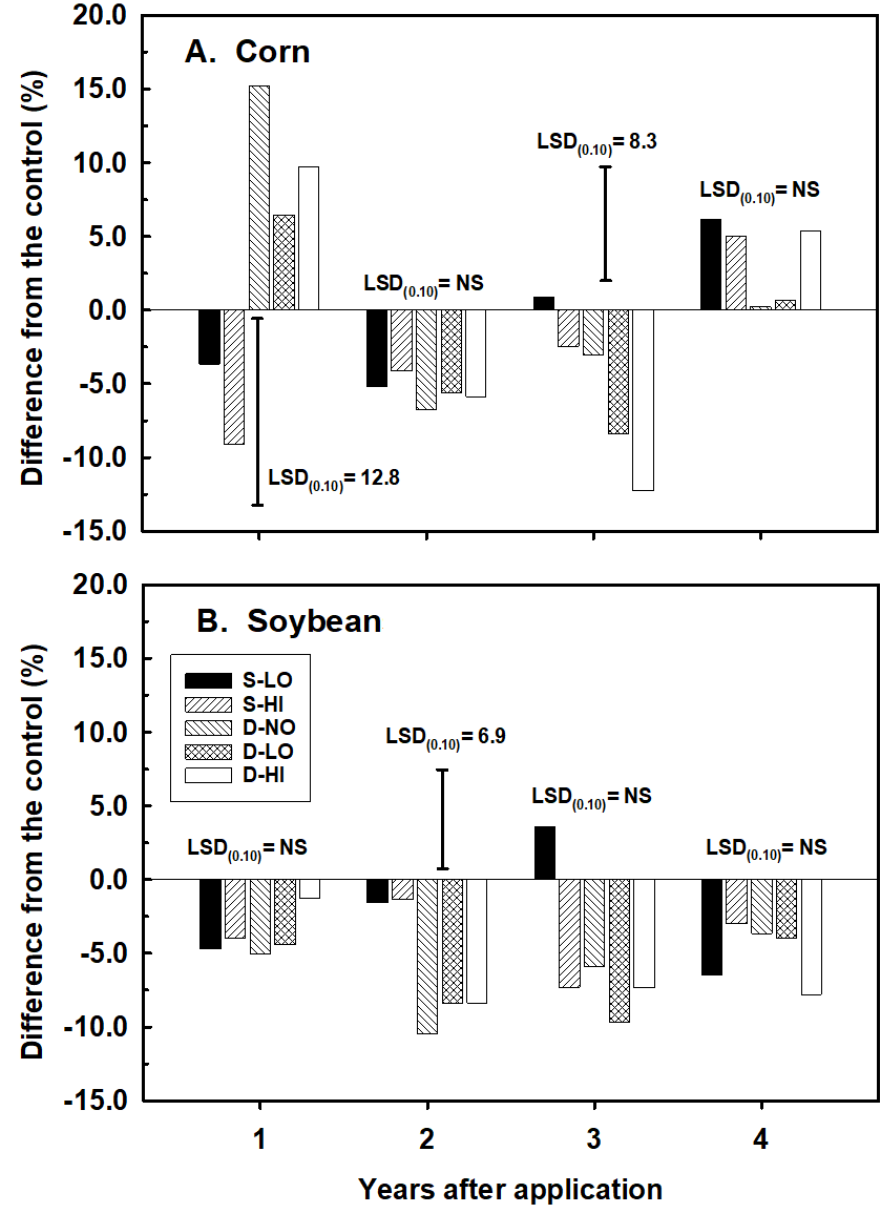
Figure 6. ( A , B ) Grain yield differences from the control plots for ( A ) corn and ( B ) soybean in response to lime treatments for all trials 1 to 4 years after treatments were initially applied. LSD (0.10) is least significant differences at p ≤ 0.10. (Abbreviations: CTRL, control; S-LO, surface 3.4 Mg ha −1 ; S-HI, surface 6.7 Mg ha −1 ; D-NO, deep tillage no lime; D-LO, deep placement 3.4 Mg ha −1 ; D-HI, deep placement 6.7 Mg ha −1 ; NS, not significant).